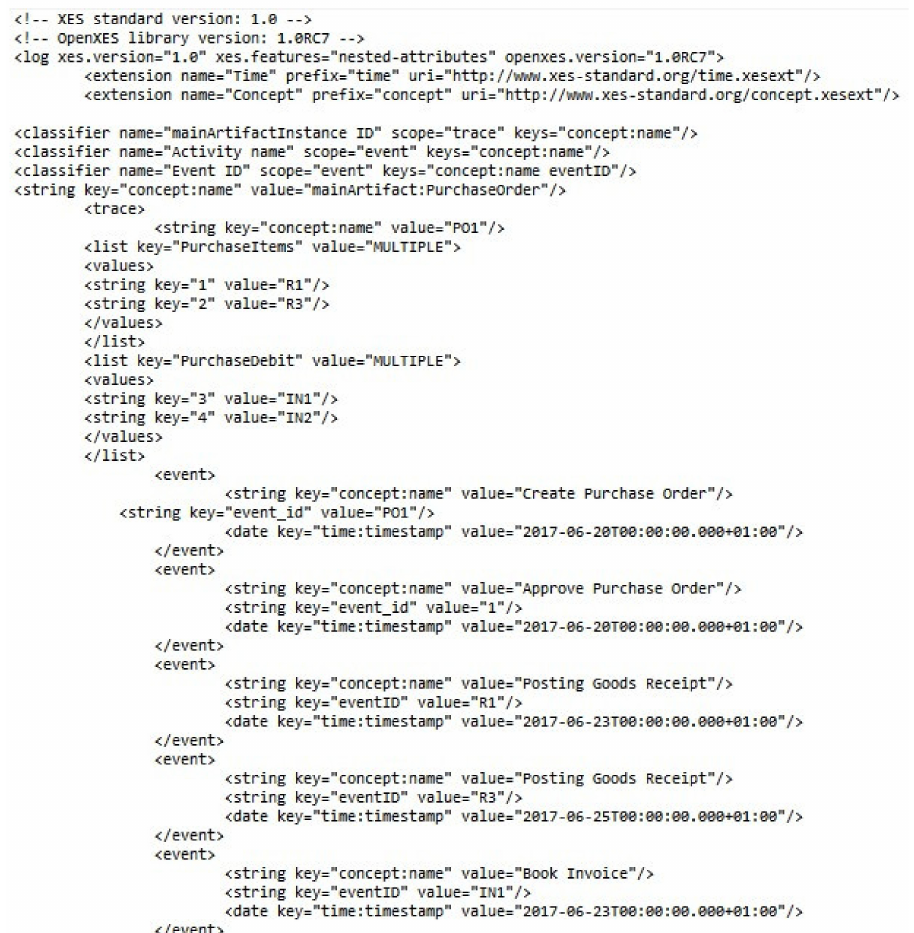
Figure 6. A part of the XES document for the purchase order